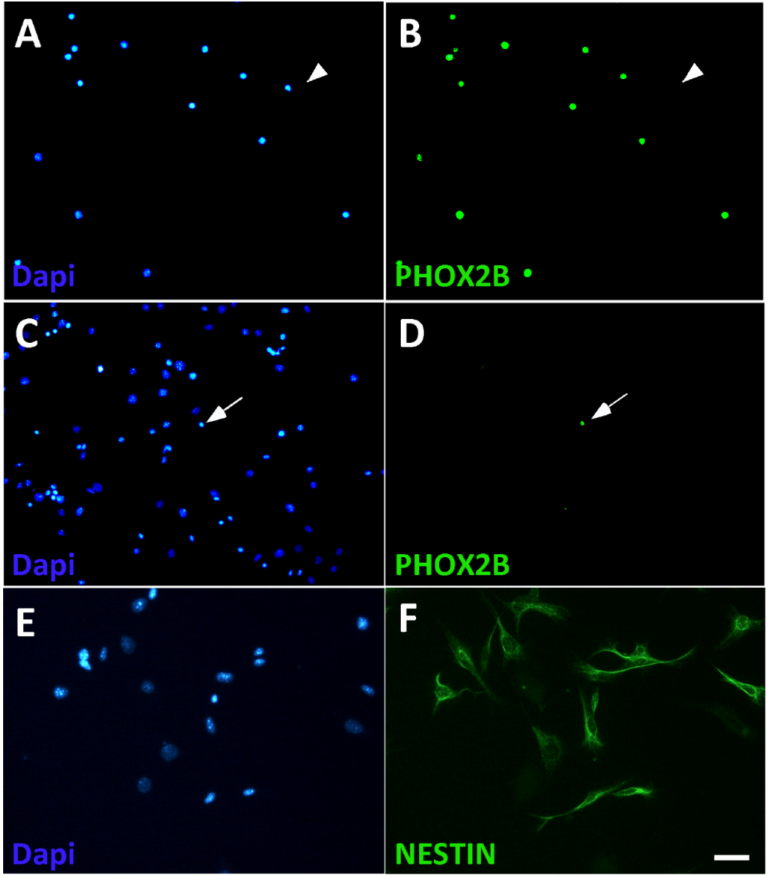
Figure 3. Isolation of chromaffin cells from dissociated adrenal cells by L1CAM panning. L1CAM- positive ( A , B ) and L1CAM-negative ( C , D ) cell populations were plated after panning and analyzed for the presence of chromaffin cells by co-staining by Dapi for cell nuclei ( A , C ) and PHOX2B ( B , D ). Most L1CAM-positive cells express PHOX2B ( A , B ), whereas the L1CAM-negative population is virtually devoid of PHOX2B-positive cells ( C , D ). Arrowheads point to a PHOX2B-negative cell in the L1CAM-positive population ( A , B ), arrows point to a PHOX2B-positive cell in the L1CAM-negative population ( C , D ). NESTIN expression is detected in most L1CAM-negative cells ( E , F ). Magnification bar, 60 µ m.